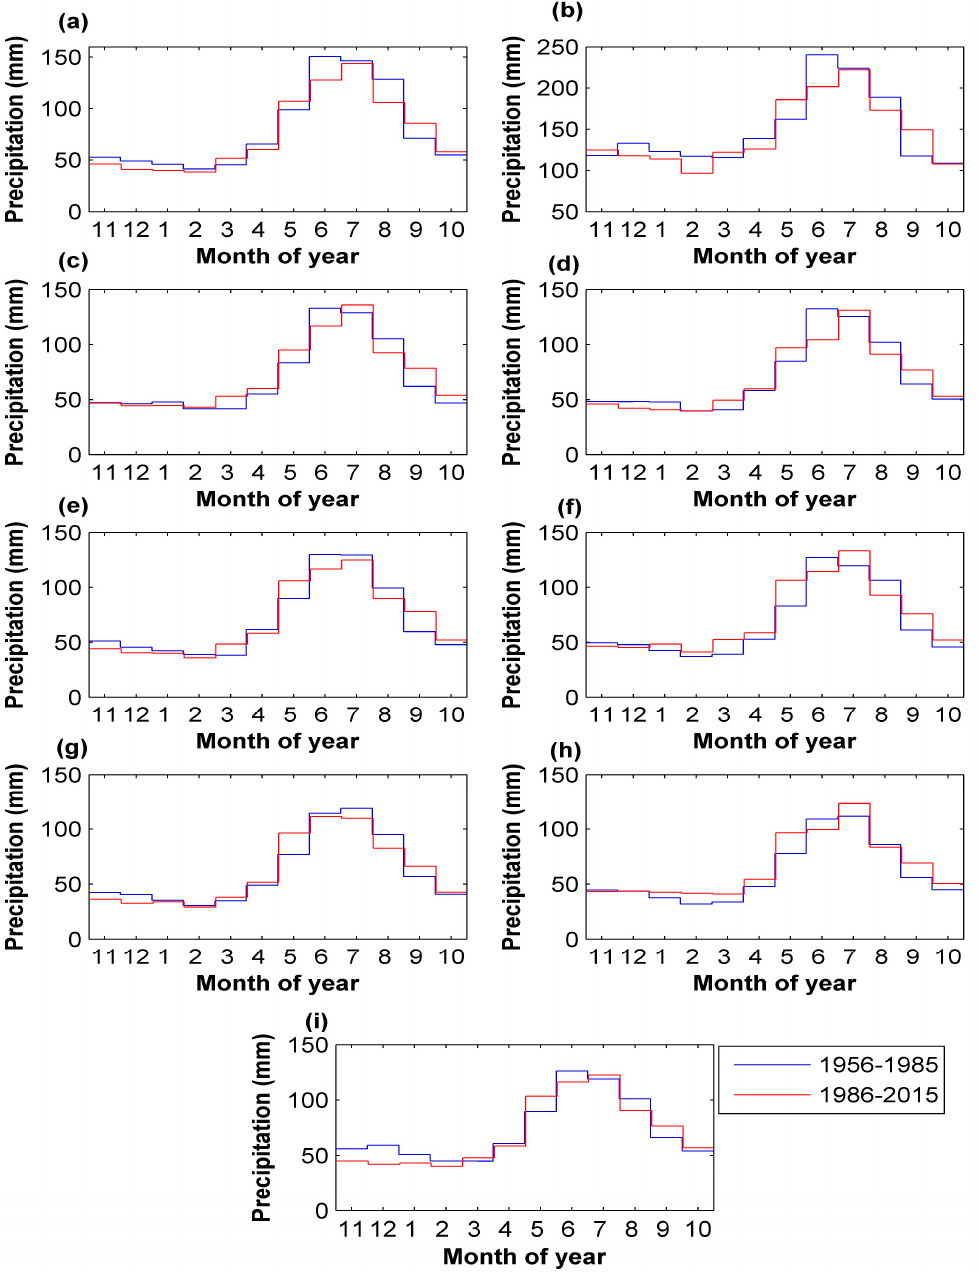
Figure 2. Annual cycle of mean monthly precipitation for two subsequent 30 ‐ year periods at ( a ) Ba ń ska Wy ż na; ( b ) Kasprowy Wierch; ( c ) Szaflary; ( d ) Bia ł ka Tatrza ń ska; ( e ) Limanowa; ( f ) Kro ś cienko; ( g ) Nowy S ą cz; ( h ) Muszyna; and ( i ) Krynica. Between the time periods 1986–2015 and 1956–1985, significant differences in precipitation were identified for December, June, and August (decreases), as well as for March, May, and September (increases).